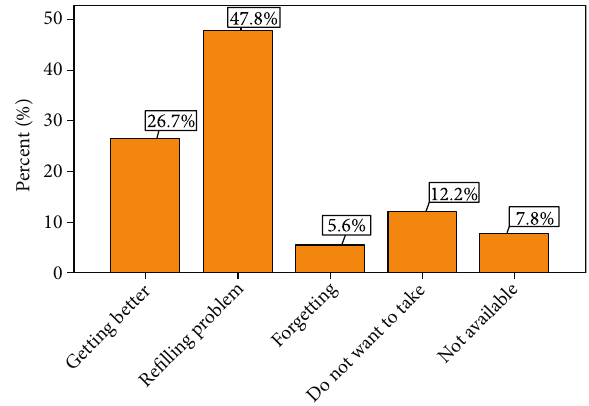
Figure 1: Reasons reported by HF patients to discontinue their